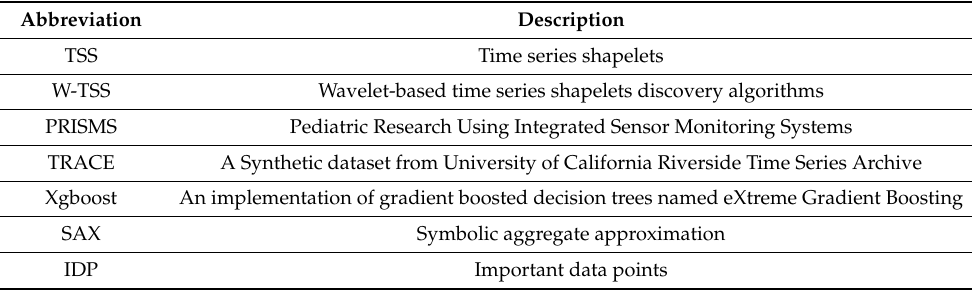
Table A2. List of abbreviations and acronyms used in this